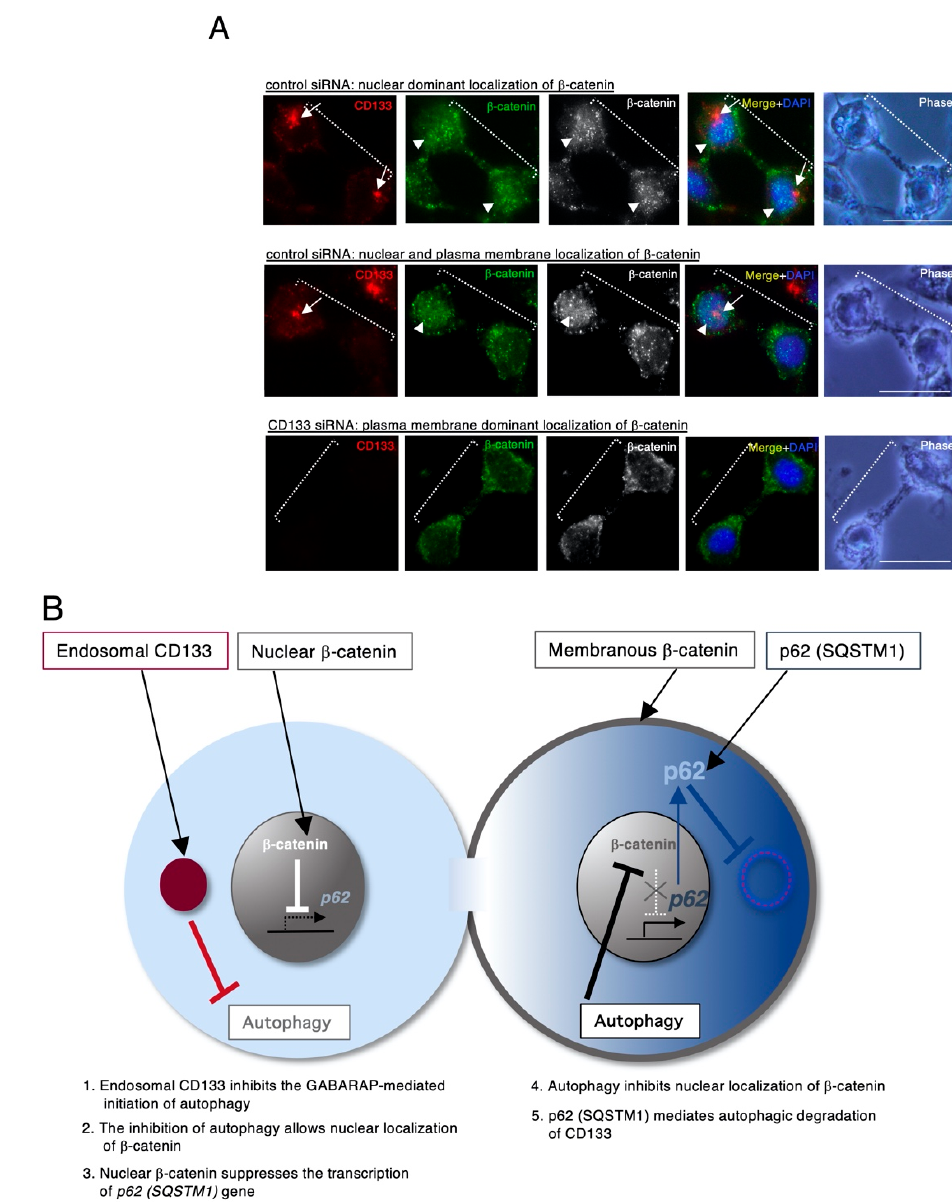
Figure 2. Symmetry-breaking of autophagic activity during cytokinesis in CD133-positive human neuroblastoma cells. ( A ) Representative images of CD133 and β -catenin during cytokinesis in SK-N-DZ cells transfected with control or CD133 siRNA. CD133 is red, β -catenin is green, and DAPI (DNA) is blue. Phase contrast images are also shown. Arrows show the pericentrosomal localization of CD133. Arrowheads show the predominant nuclear localization of β -catenin. Scale bars: 10 μ m. ( B ) Symmetry-breaking of autophagic activity during cytokinesis. During cytokinesis, CD133 endo- somes asymmetrically localize to the centrosome and suppress autophagy. In autophagy-repressed daughter cells, the nuclear localization of β -catenin is enhanced and suppresses p62/SQSTM1 gene expression. On the other hand, in daughter cells in which CD133 endosomes do not localize to the